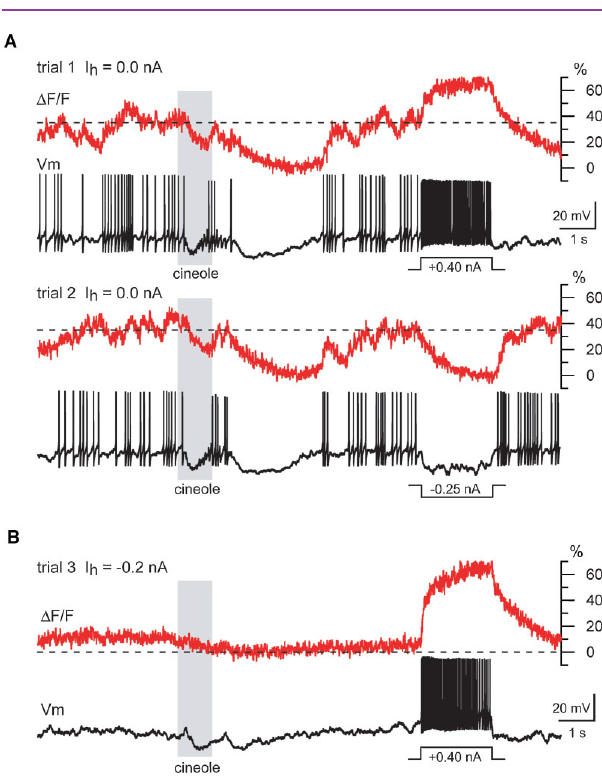
Figure3. Calciumsignaldynamicsuponodorpresentationandintracellu- lar current injection . ( A ) Two successive trials with odor cineole (15seconds of the 24 acquired for each trial are displayed) illustrating (i) the elevated base- line fluorescence (corresponding to a mean baseline firing rate of 5sp/second, typical for PNs), (ii) the odor-evoked fluorescence modulation (mostly below baseline in this example), and (iii) inter-trial response reliability. Current pulses (top: positive; bottom: negative) were injected toward the end of each trial, to evaluate the dynamic range of the fluorescence signal. F0: minimum fluores- cence, reached here during both odor- and pulse-evoked hyperpolarizations. Stippled line: mean baseline fluorescence, determined before odor pulse. ( B ) Same PN, held slightly hyperpolarized by constant current (Ih) to minimize mean baseline fluorescence: depolarizing current pulse injection evokes cal- cium signal summation to level comparable to that in A (top). This indicates that PN baseline F in vivo is